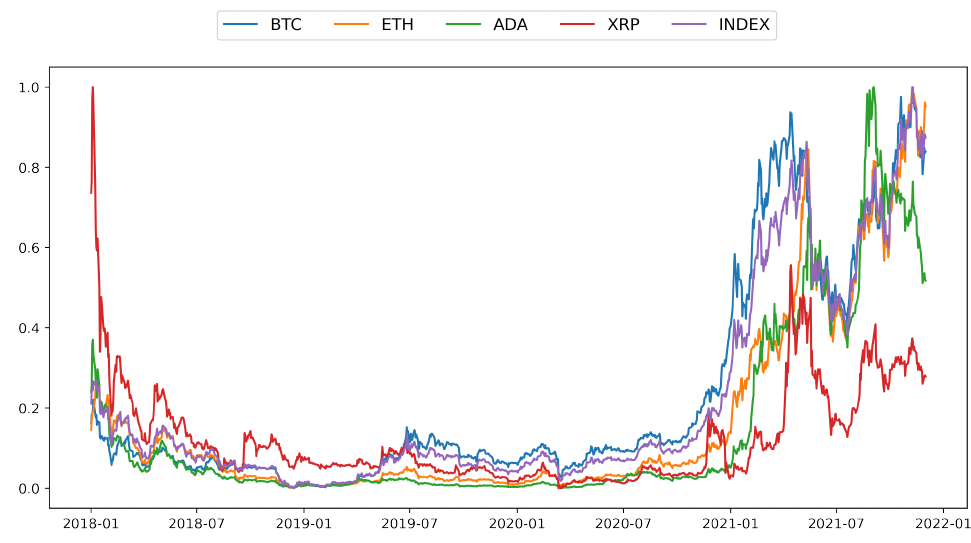
Figure 1. BTC, ETH, ADA, XRP, and INDEX price dynamics on the same